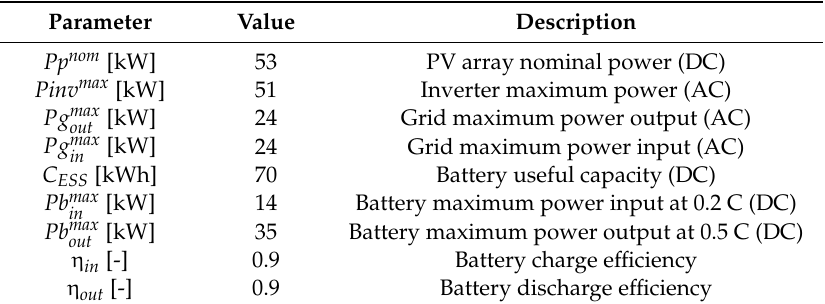
Table 1. Components size.